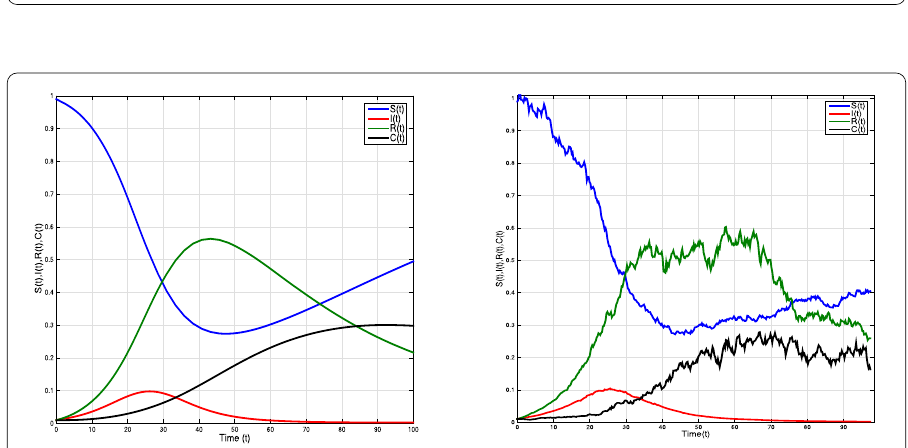
Figure 2 Shows numerical simulations of stochastic model (2) when R s 0 = 1.3 > 1, with η = 0.09, ξ = 1.3, β = 0.05, σ = 0.9, α = 0.36, γ = 0.1; τ = 1 and white noises ν 1 = 0.1, ν 2 = 0.09, ν 3 = 0.09, ν 4 = 0.07. The model has a unique ergodic stationary distribution and the infection is persistent